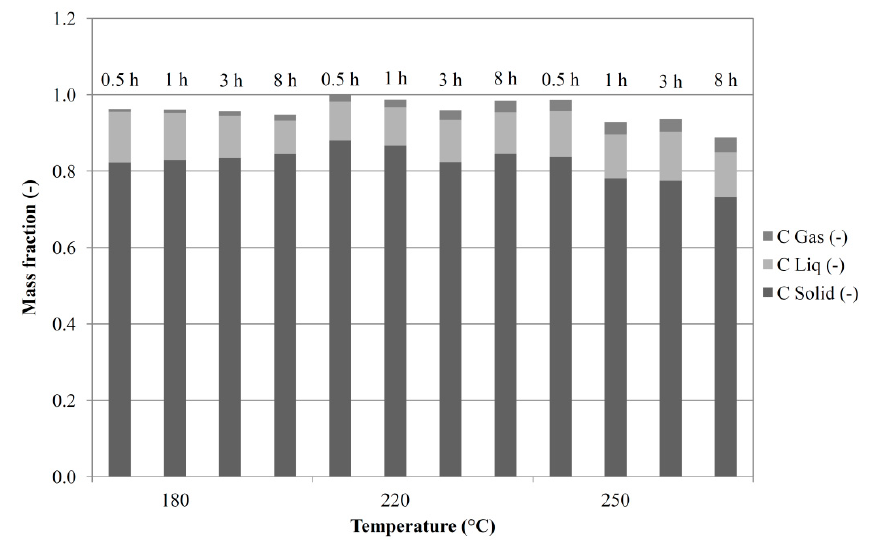
Figure 5. Carbon balance of grape seeds.